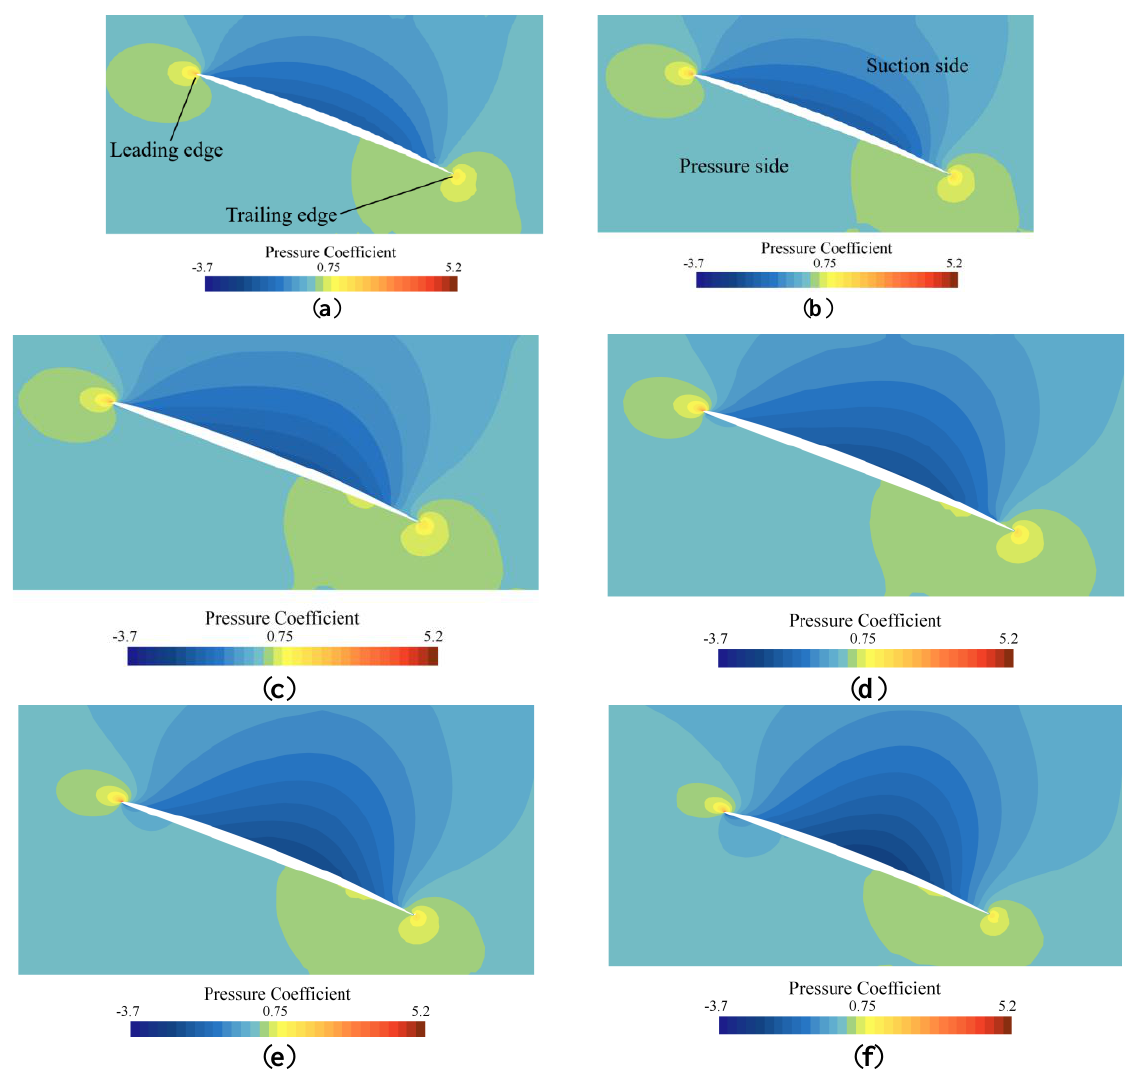
Figure 14. Pressure coefficient distribution of three-dimensional airfoil section at propeller 0.8 r/R for propeller Kap00 ( a ), Kap01 ( b ), Kap02 ( c ), Kap03 ( d ), Kap04 ( e ) and Kap05 ( f ).